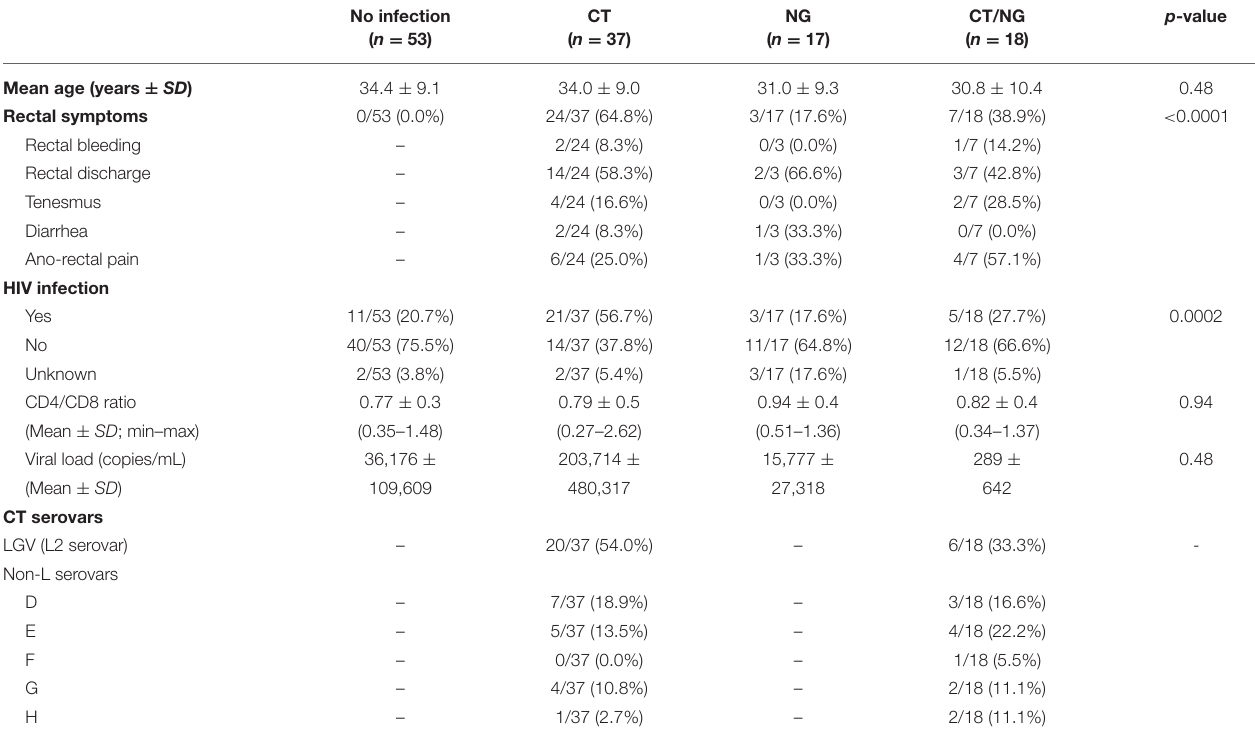
TABLE 1 | Primary demographic and clinical characteristics of the enrolled